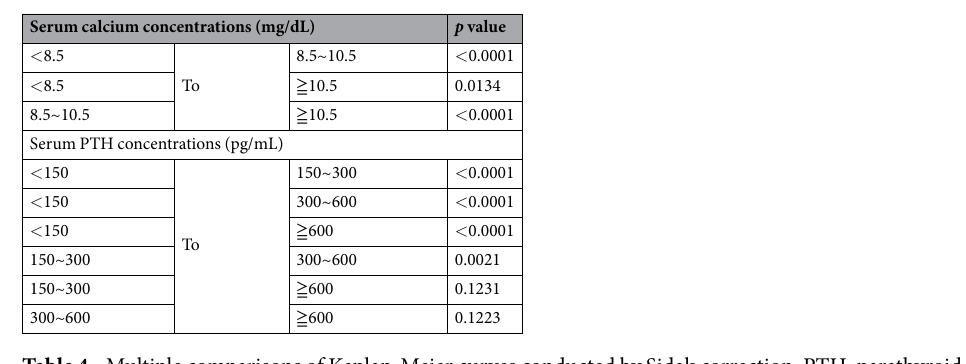
Table 4. Multiple comparisons of Kaplan-Meier curves conducted by Sidak correction. PTH, parathyroid